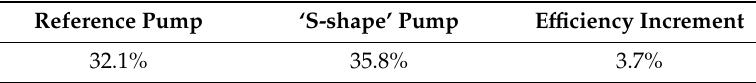
Figure 11. Response surface of pump efficiency. Table 5. Result of shape optimization for pump efficiency.